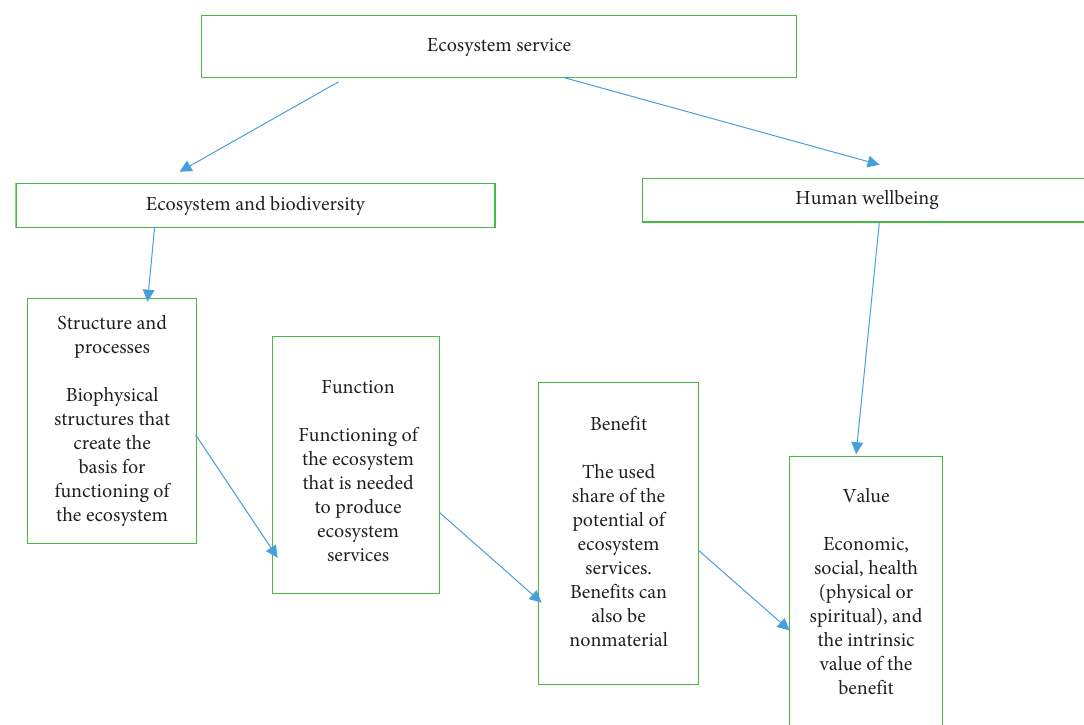
Figure 1: The cascade model with integrated indicators of ecosystem service (La Notte et al.